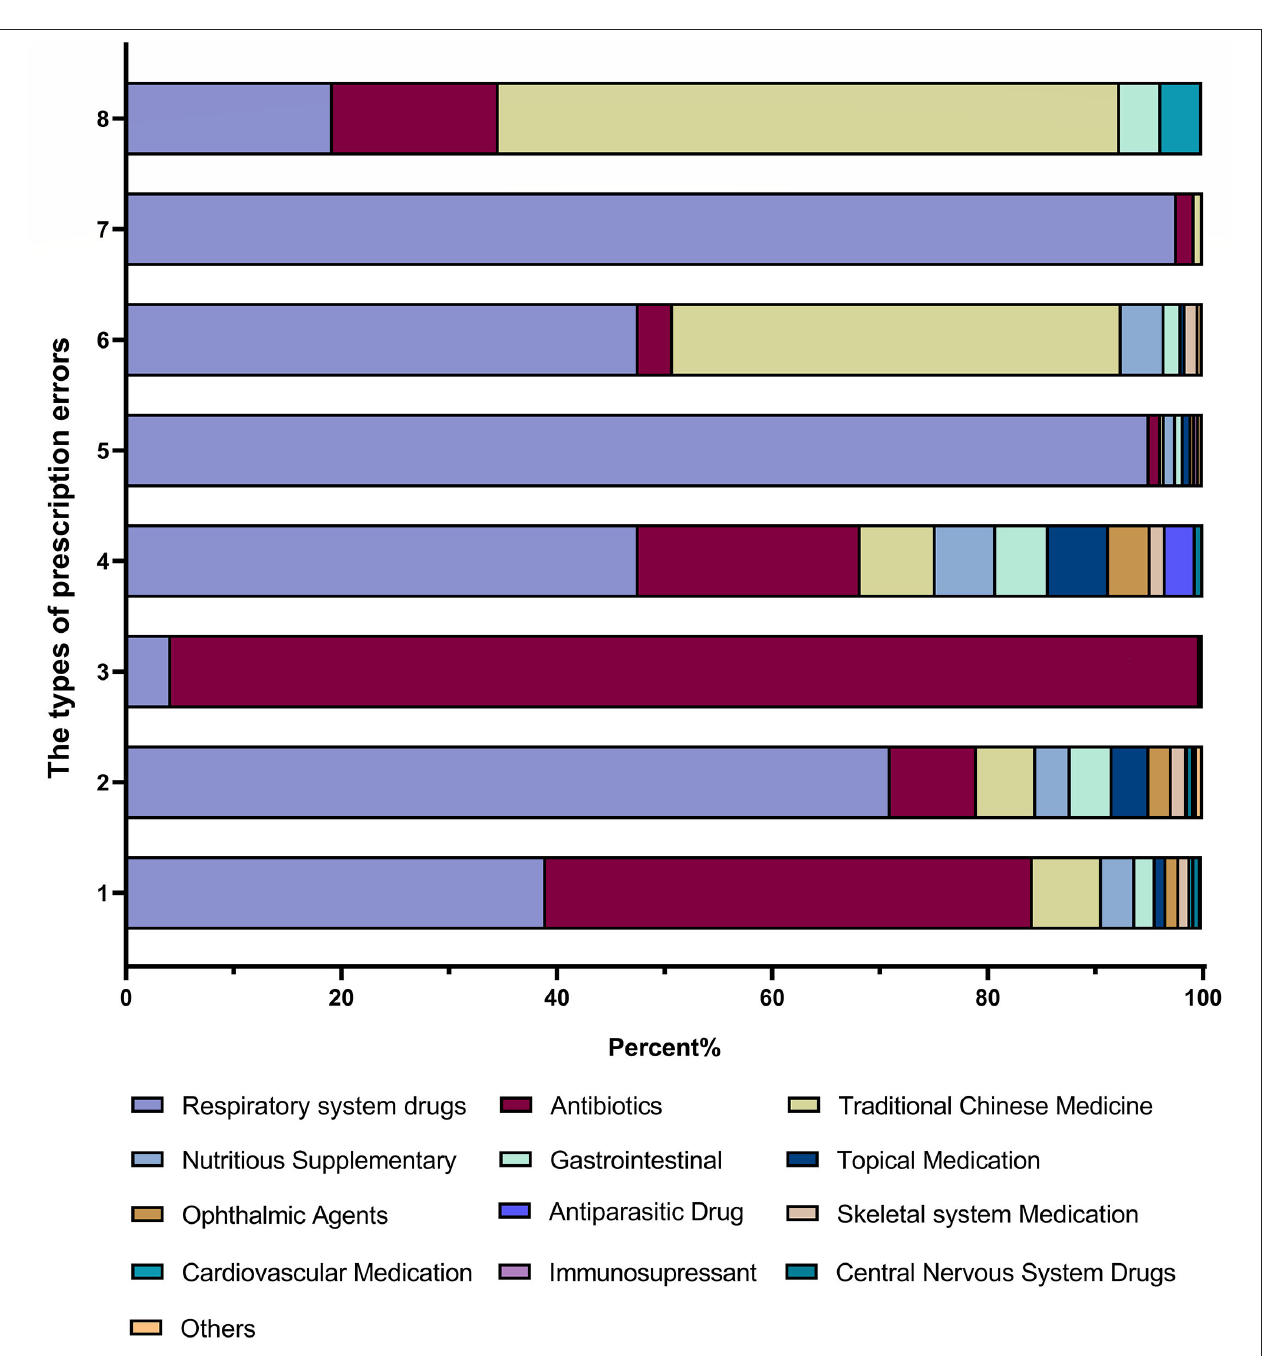
FIGURE 3 | Types of prescription errors by medication